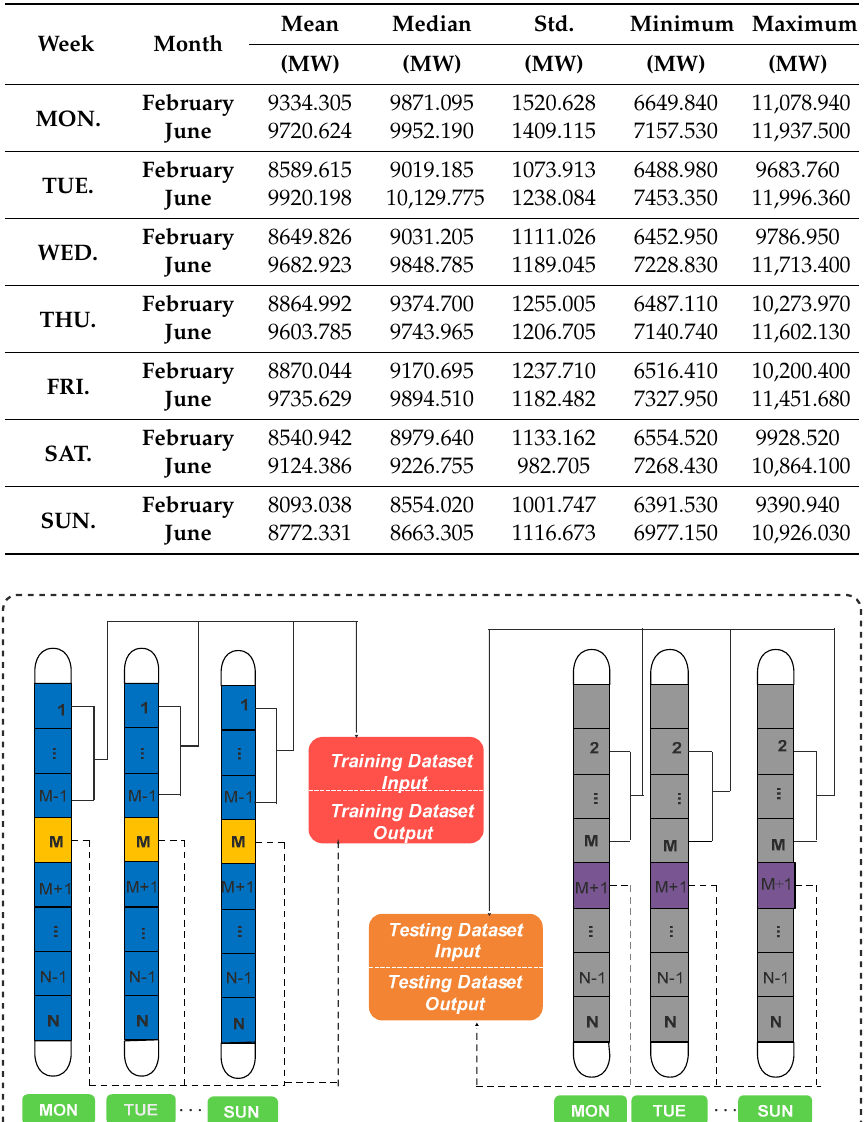
Table 3. Statistical values of data used in this study.